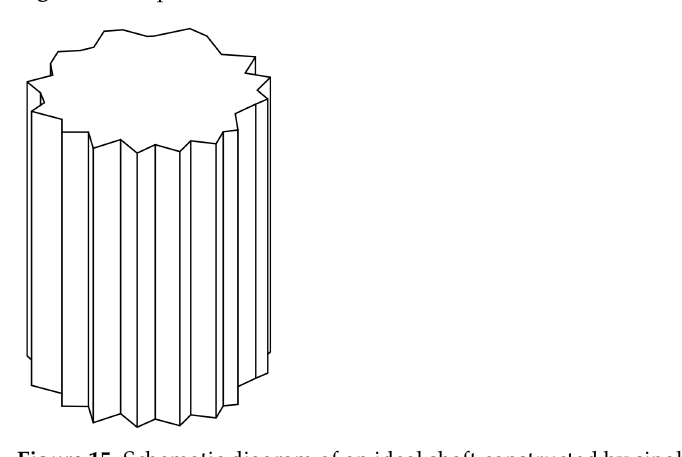
Figure 14. Dispersion coefficients of four shafts.